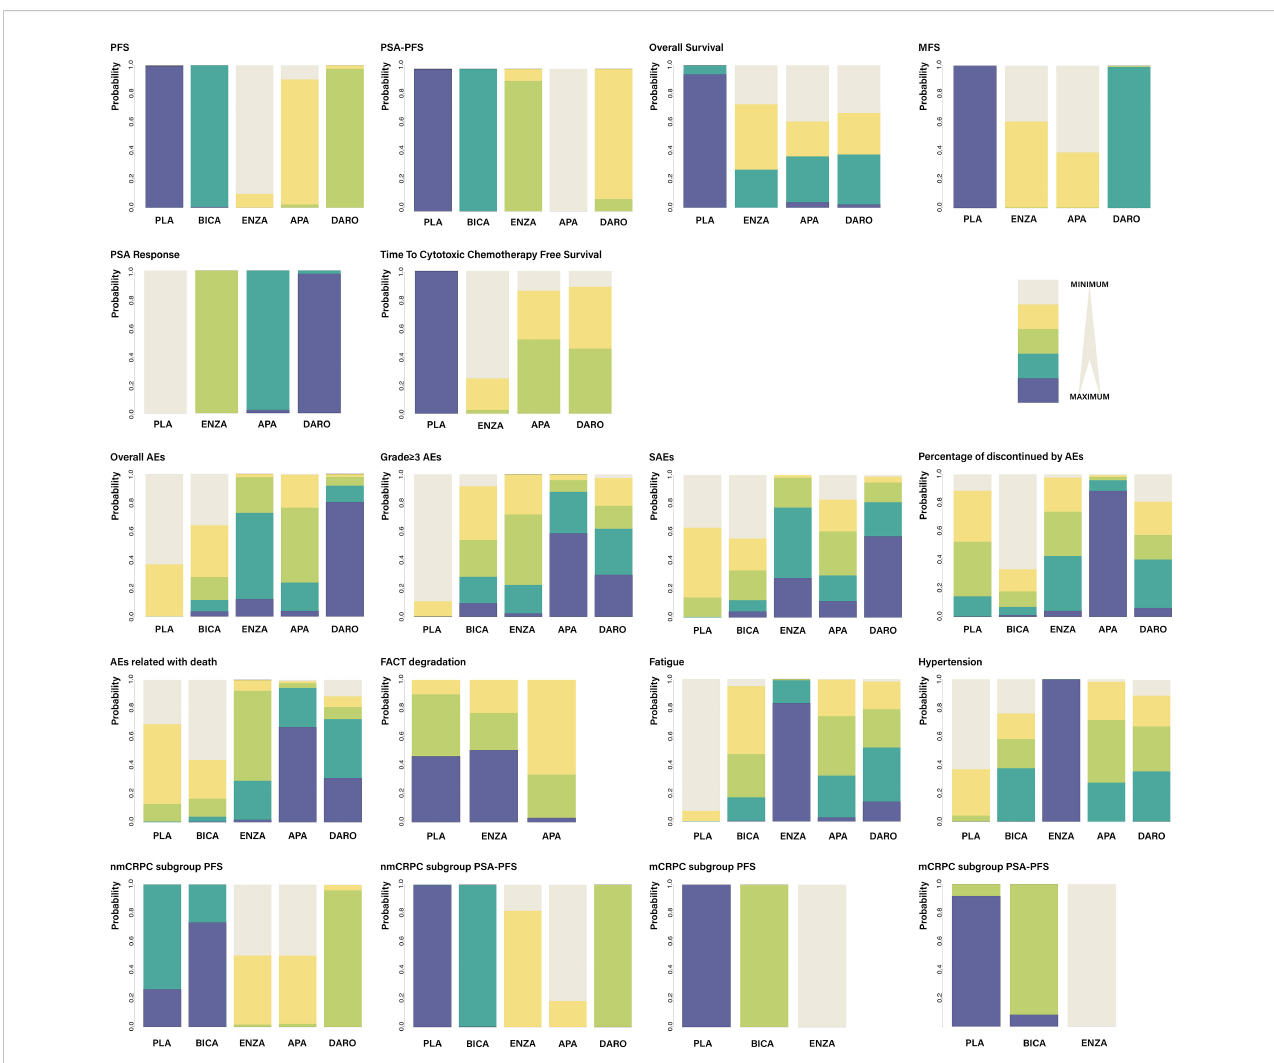
FIGURE 3 The probability ranking plot of outcomes. The probability ranking plot is the visualized display of rank probability Supplementary Table showed in additional fi le 2. The color depth represents the rank of